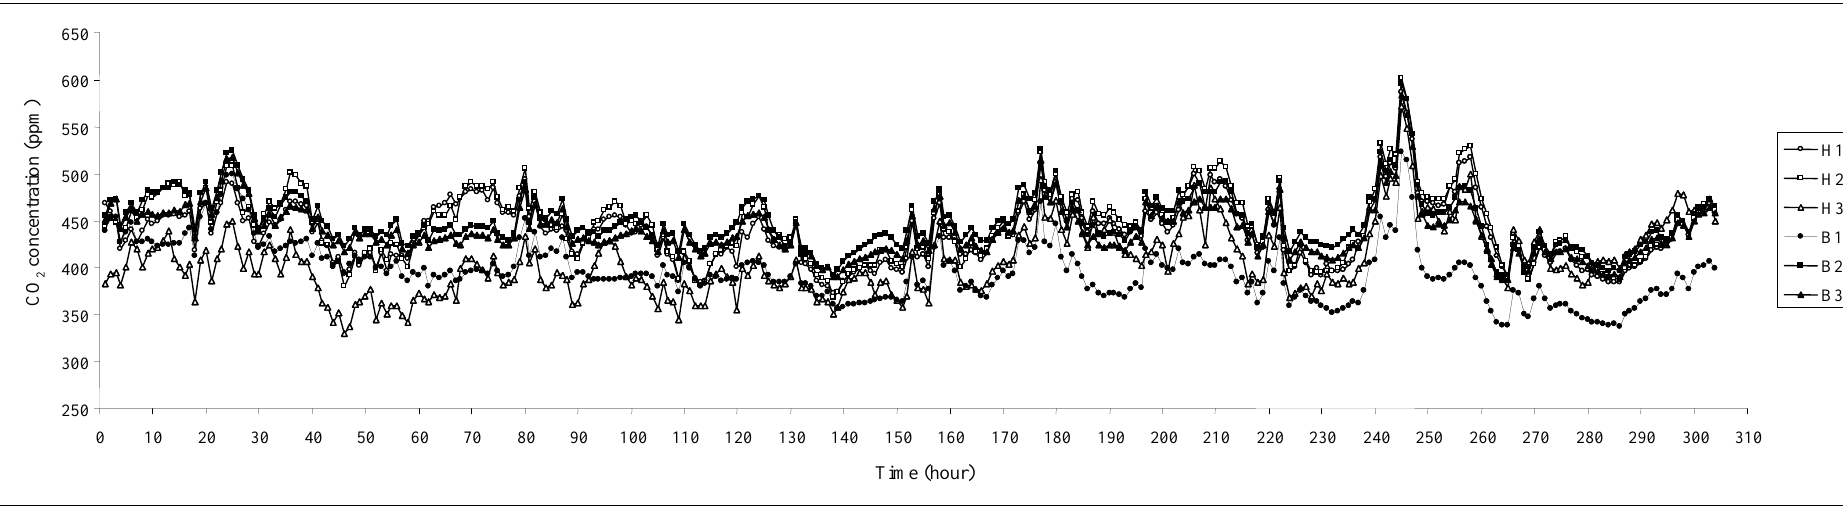
Figure 3a. A comparison of variations in mean hourly concentration values of CO duration of 304.